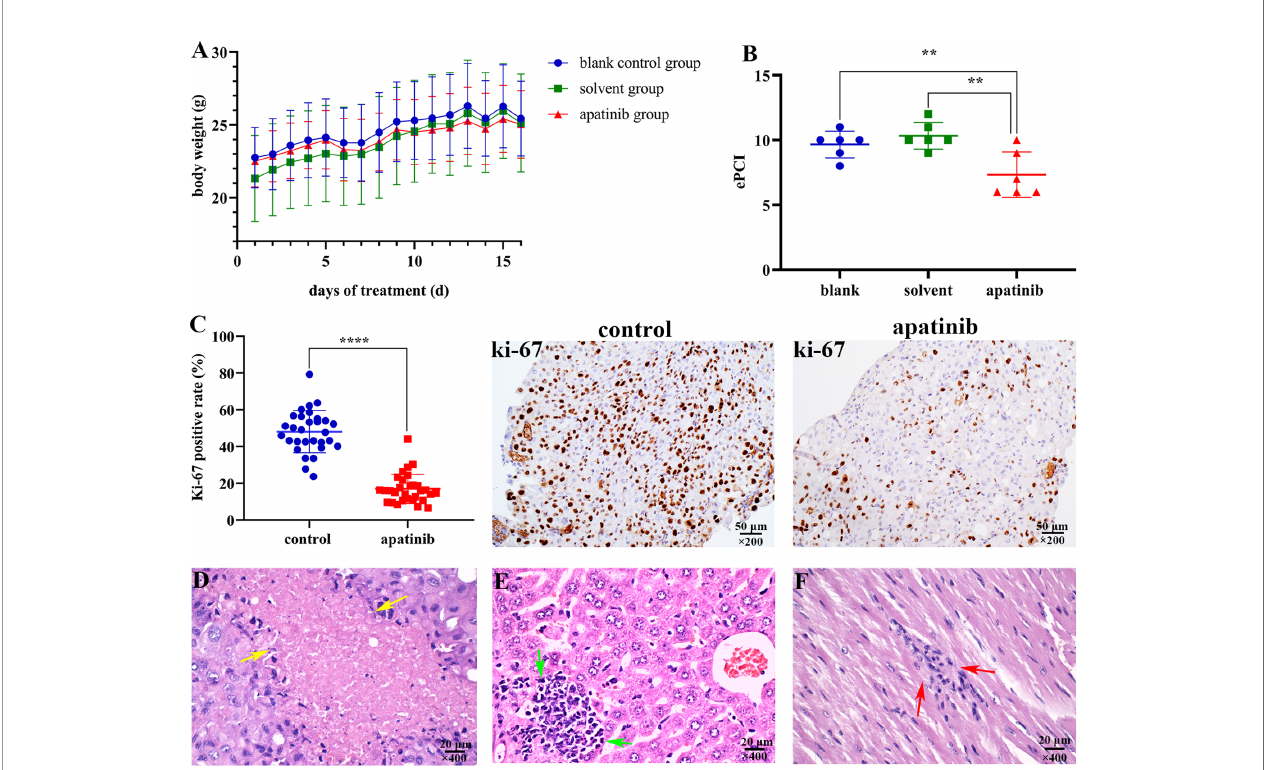
FIGURE 6 | Apatinib inhibits tumor growth and metastasis in vivo . (A) Apatinib did not affect the weight of models during the treatment period. (B) Comparison of ePCI score among three groups, apatinib signi fi cantly decreased the ePCI compared with control groups (** P < 0.01). (C) The positive rate of Ki-67 in apatinib group was signi fi cantly lower than that in control group (**** P < 0.0001), magni fi cation, ×200. (D) Coagulation necrosis was found in apatinib treatment group, magni fi cation, ×400. (E) Focal lymphoid in fi ltrations in the liver of apatinib group, magni fi cation, ×400. (F) Focal lymphoid in fi ltrations in the cardiac muscle of apatinib group, magni fi cation, ×400. ePCI, experimental peritoneal cancer index.